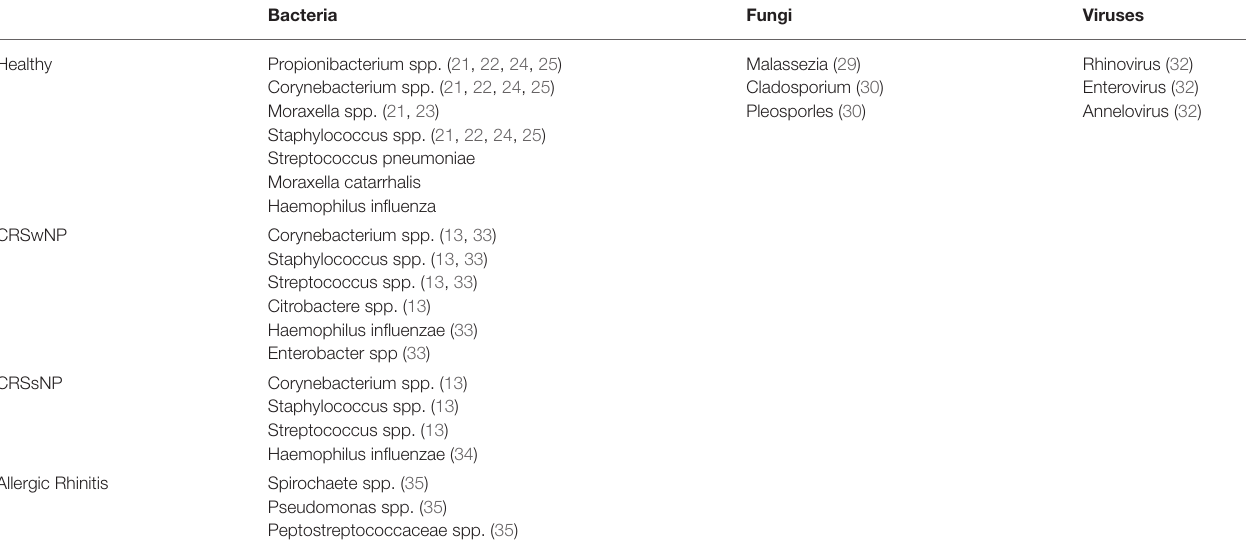
TABLE 1 | Comparison Of Common Bacteria, Viruses And Fungi In Normal, Allergic Rhinitis, CRSwNP And CRSsNP. Bacteria Fungi